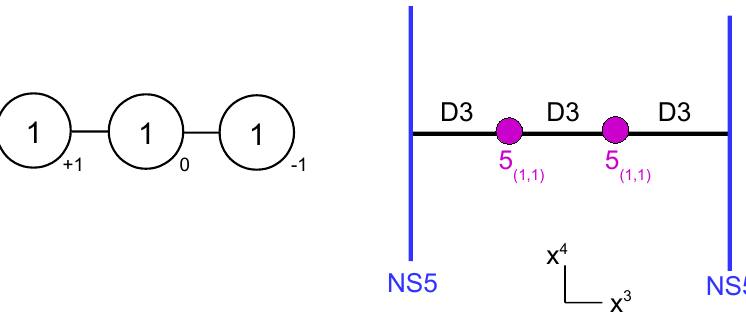
Figure 6 . Quiver diagram of the T A theory (subscripts indicate Chern-Simons levels) and associ- ated brane